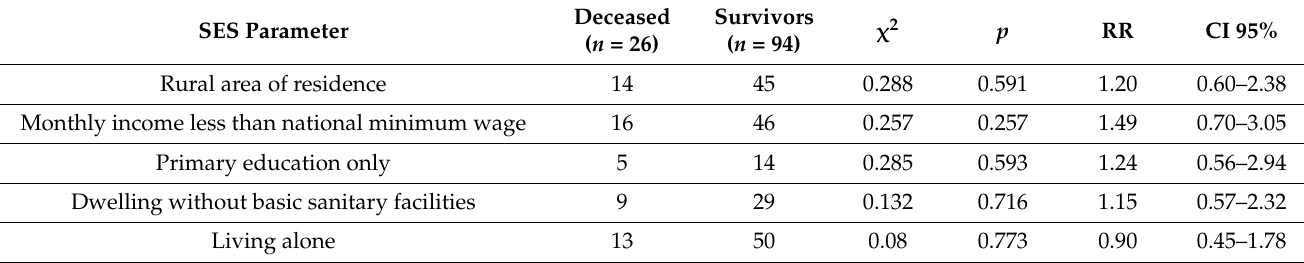
Table 5. SES factors influencing mortality risk in acute HF (in-hospital and at 1-month follow-up).